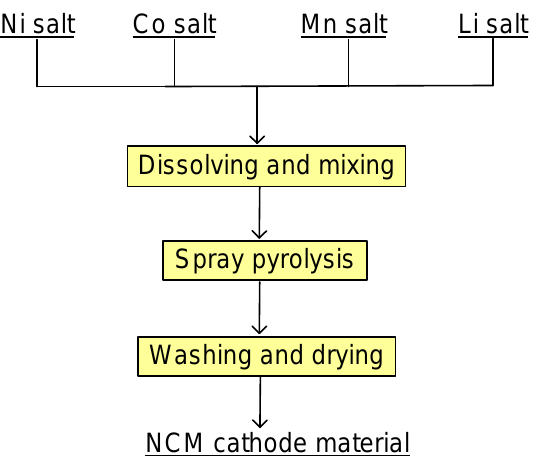
Figure 2. Flowchart for the synthesis of NCM cathode material using the spray pyrolysis method.